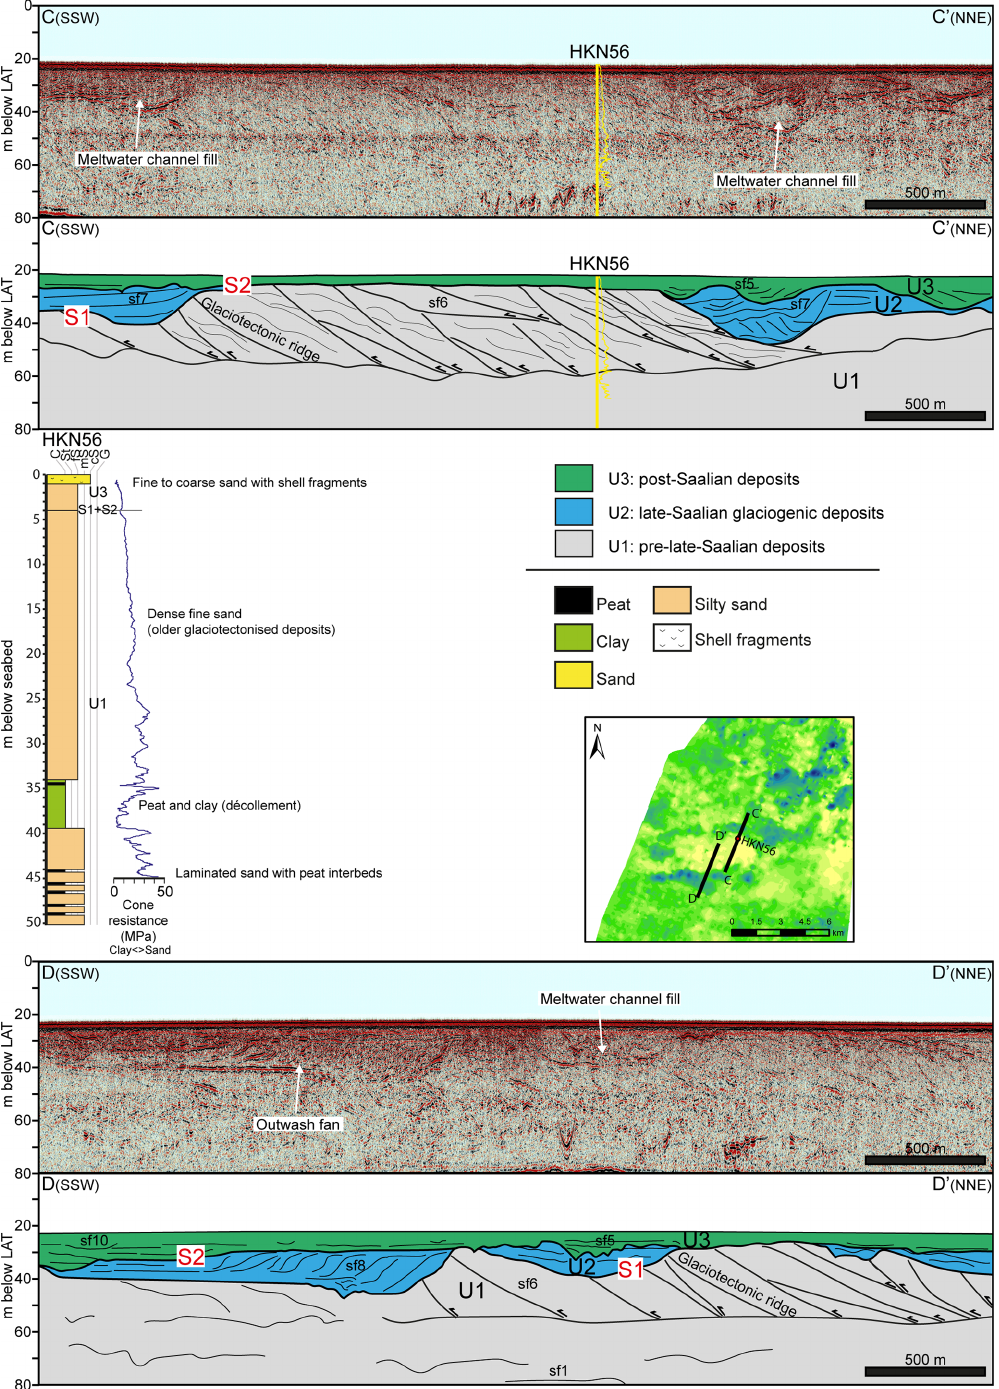
Figure 5. Stratigraphic sections (multi-channel sparker) through the glaciotectonic ridge in the middle sector of the HKN wind-farm area. In seismic section C–C (cid:48) , the side of the ridge is incised by proglacial meltwater channel fills. Borehole HKN56 was recovered at the top of the ridge. Only the upper 50m of the borehole is shown. Cone resistance from a CPT obtained at the same site is displayed on the side of the borehole and in the seismic profiles. In section D–D (cid:48) , outwash sediments (outwash fan) prograde inside a shallow depression incised in the southern flank of the ridge. For the location of the seismic profiles and the borehole see the inset map (same map from Fig. 3). Grain sizes – C: clay, St: silt, fS: fine sand, mS: medium sand, cS: coarse sand, G: